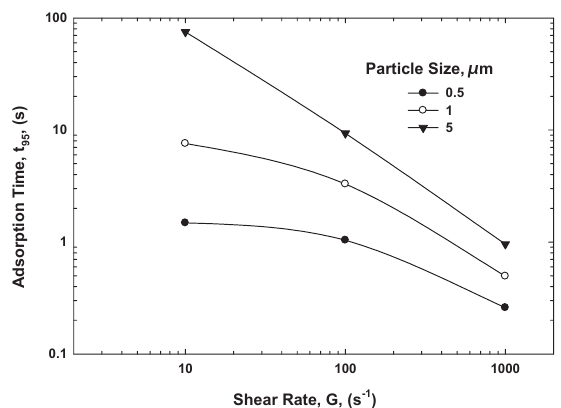
Fig. 2 The effect of shear rate on theoretical adsorption times for a 10 million molecular weight polymer at a slurry concentration of 1% by